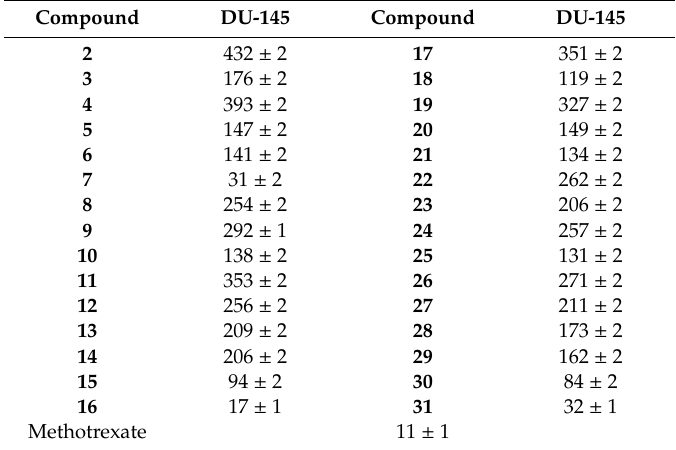
Table 3. Antiproliferative activity (IC 50 in µ M) of chalcones ( 2 – 16 ) and dihydropyrazoles ( 17 – 31 ).